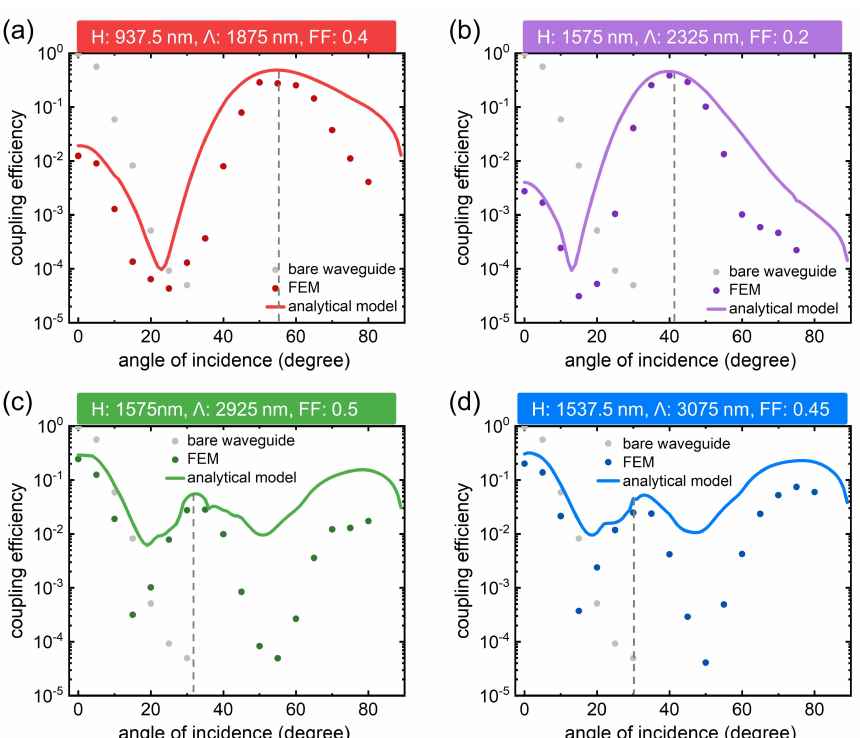
Figure 5. Coupling efficiencies of the grating-enabled waveguides computed by FEM (separated points) and the analytical model (solid lines). From ( a – d ), each graph relates to the grating configura- tion in Figure 4. The light gray dots and vertical dashed lines indicate the bare waveguide-coupled values and diffraction order angles, respectively.